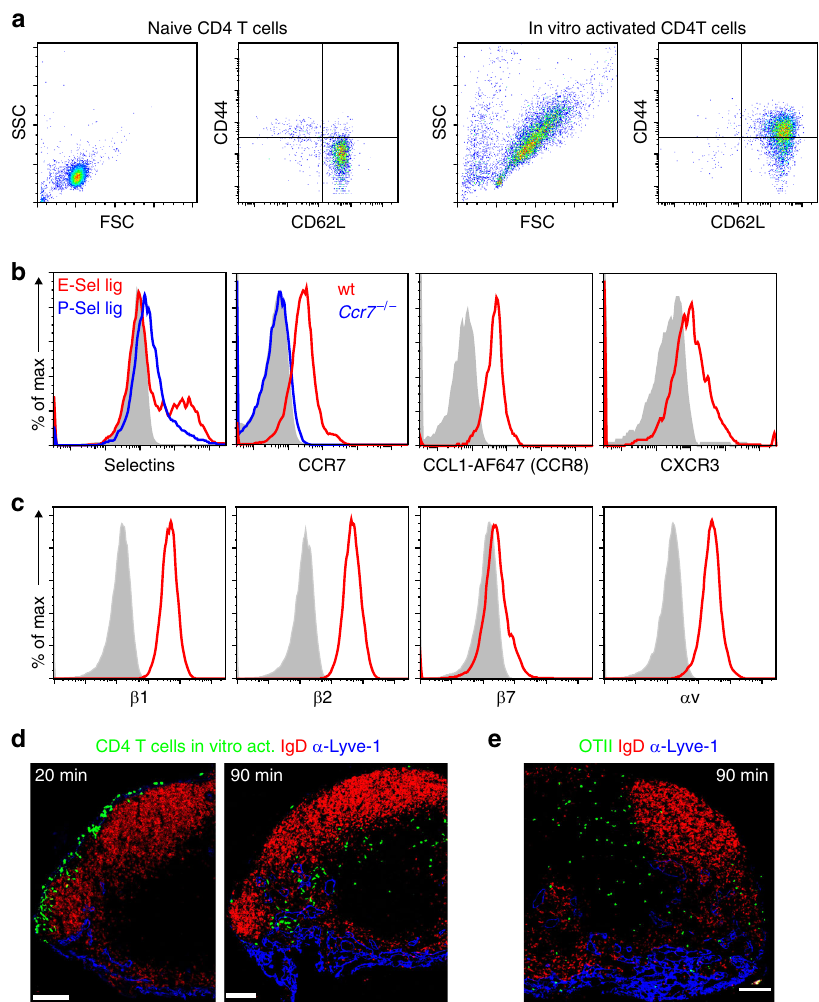
Fig. 2 Lymph-derived activated CD4 T cells enter LN parenchyma via the subcapsular sinus fl oor and express chemokine and homing receptors. a Representative FACS plots showing the forward and side scatter of naïve (left) and in vitro-activated (right) CD4 + T cells as well as the expression of CD62L and CD44. b Expression of E- and P-selectin and chemokine receptors on activated CD4 + T cells; control CCR7 staining in Ccr7 − / − activated CD4 + T cells (blue line). c Expression of integrin subunits β 1 (CD29), β 2 (CD18), β 7, and α v (CD51) on activated CD4 + T cells (red lines); gray shaded areas, isotype control. d Representative immuno- fl uorescence microscopy of popliteal LN sections 20 and 90 min after i.l. injection of in vitro-activated CD4 + T cells and e 90 min after i.l. injection of in vivo-activated GFP-OTII cells (green); red, anti-IgD; blue, anti-Lyve-1; scale bars, 100 µ